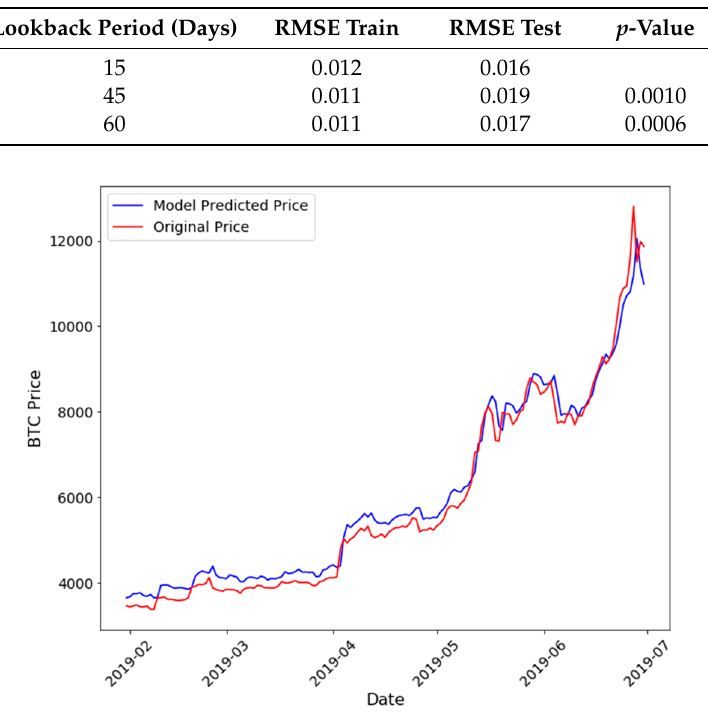
Figure 6. Bitcoin price as predicted by the GRU one-layer model with dropout and recurrent dropout.